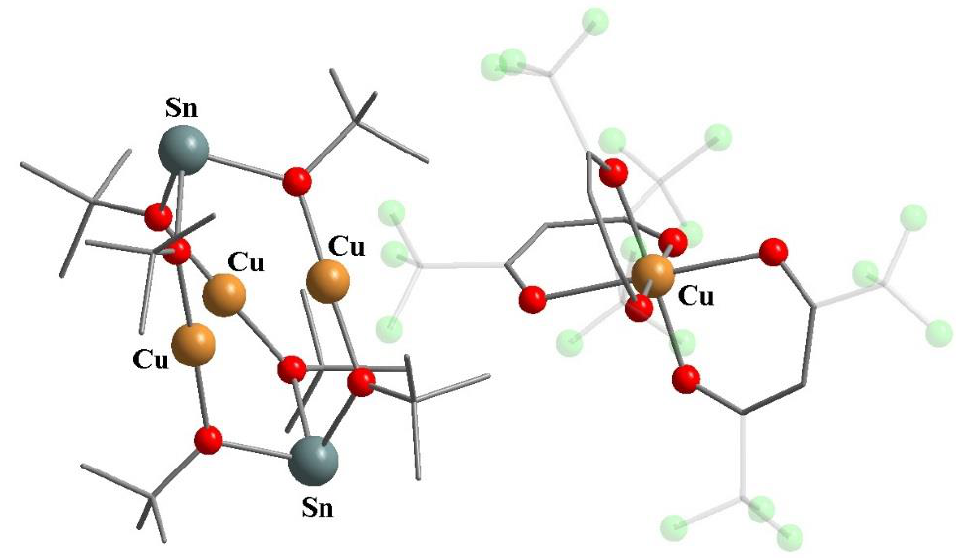
Figure 24. Molecular structure of 47 [92]. Hydrogen atoms have been omitted, some ligand groups are transparent for clarity. The cif has been retrieved from CCDC. CCDC numbers is 1056284.